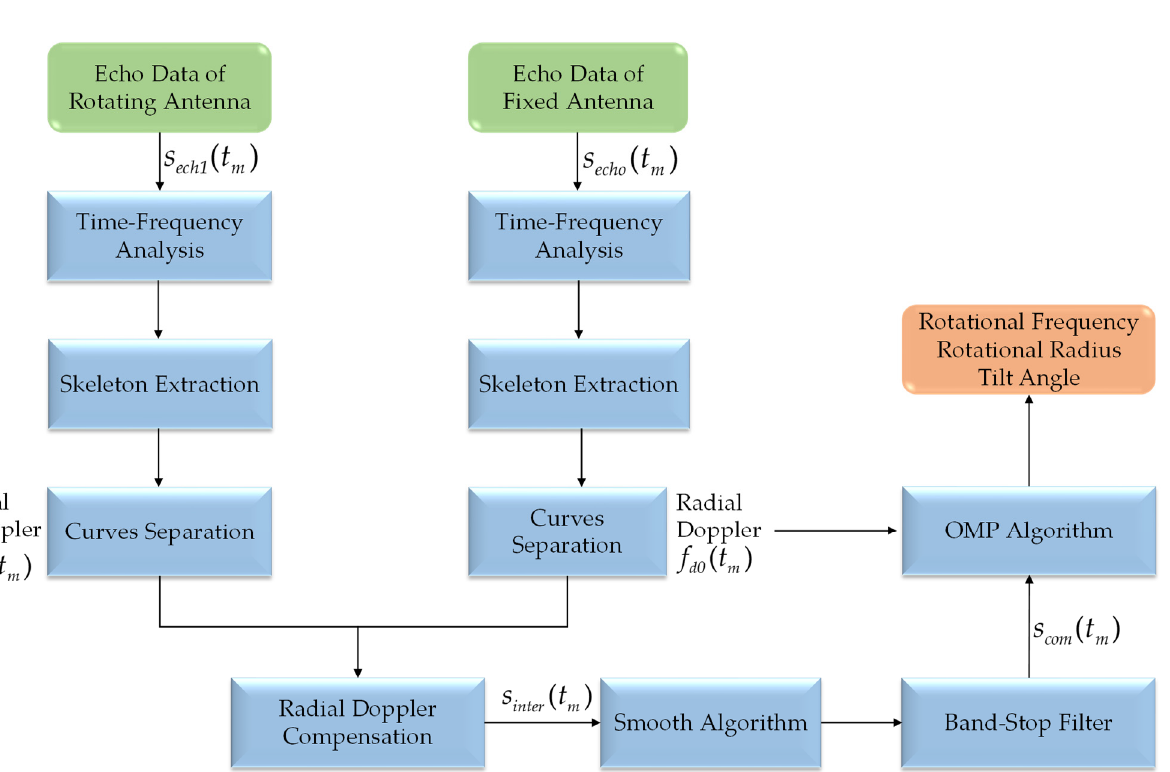
Table 1. Parameters of radar and spinning target.